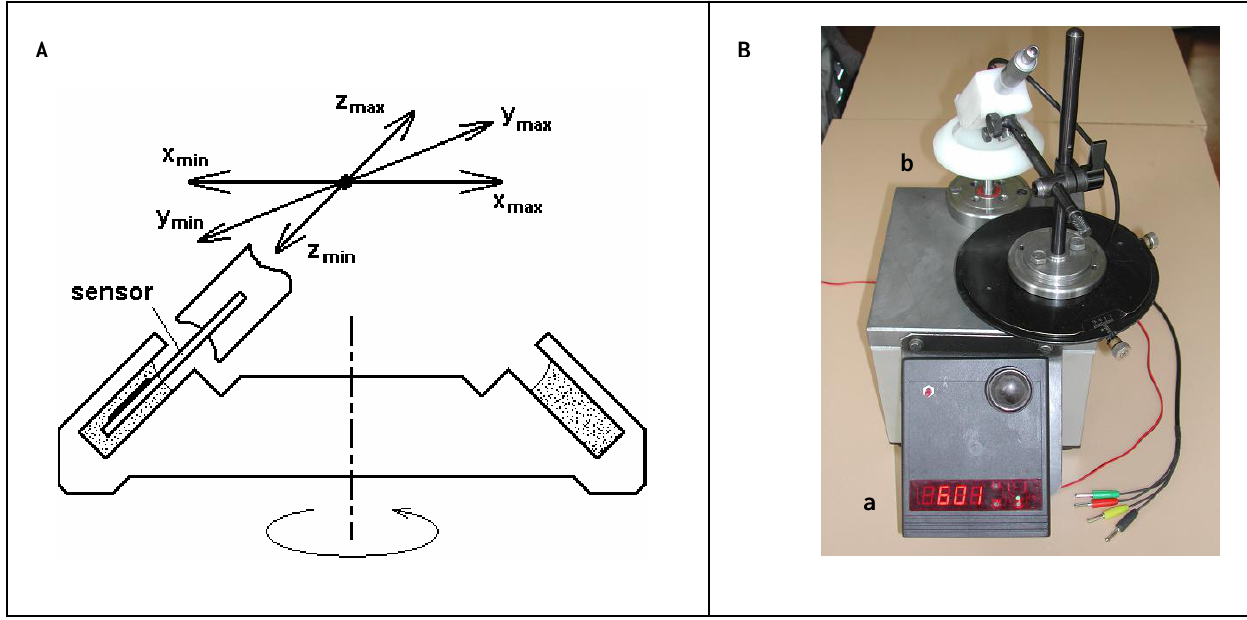
Figure 3. Scheme of the suggested device ( A ). Photography of prototype of new electrochemical device ( B ) revolution regulator ( a) and positioning of the sensor, fine 3-axis positioning of the sensor (b)